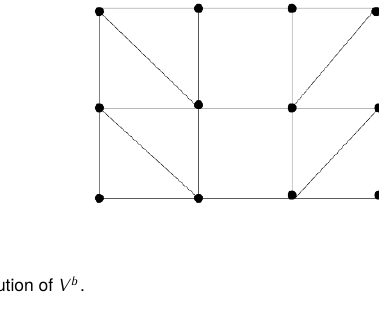
Figure 3. The Newton polytope of the resolution of V b